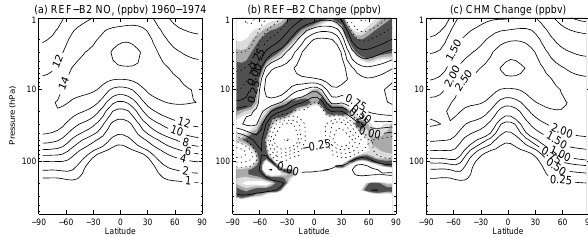
−90 −60 −30 0 30 60 90